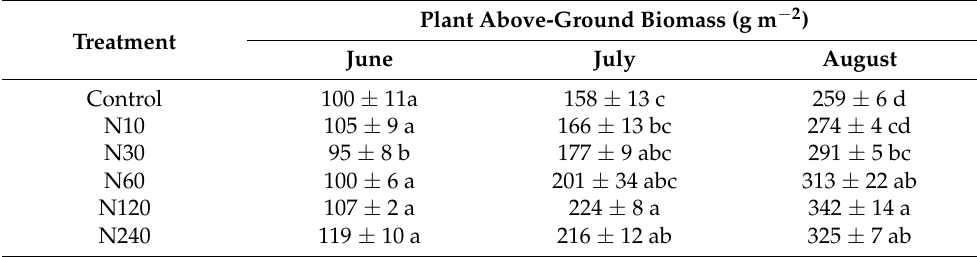
Table 3. Plant above-ground biomass as affected by different N addition rates in